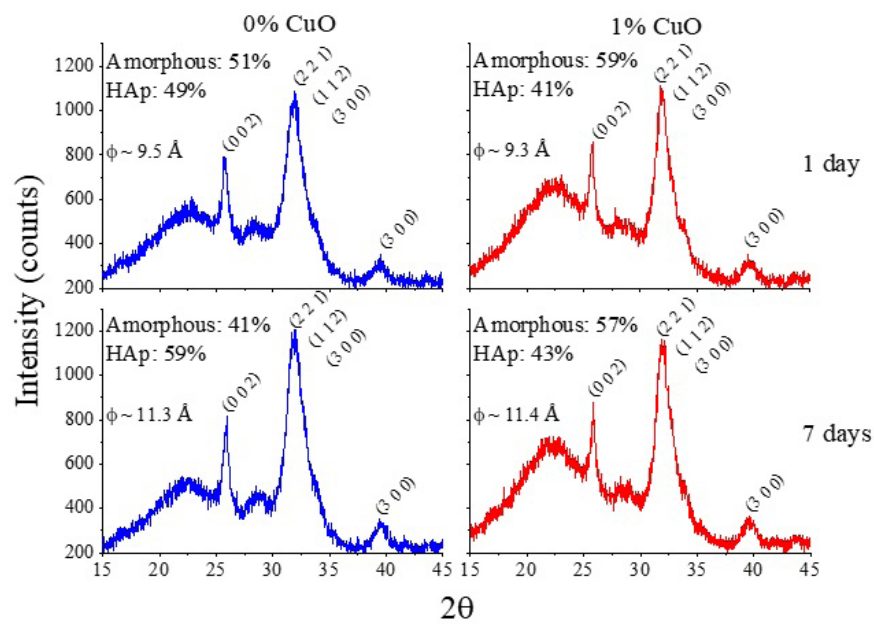
Figure 4. XRD data for the CuO-containing bioactive glasses after immersion in SBF for 1 and 7 days. The relative area (%) under the glass amorphous curve (approximately 22°) and the main crystalline diffraction peaks from hydroxyapatite are shown. The average